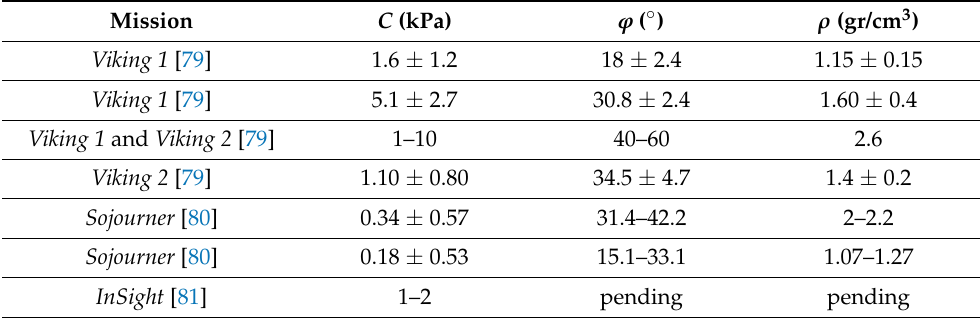
Table 2. Physical and geotechnical characteristics of the Martian